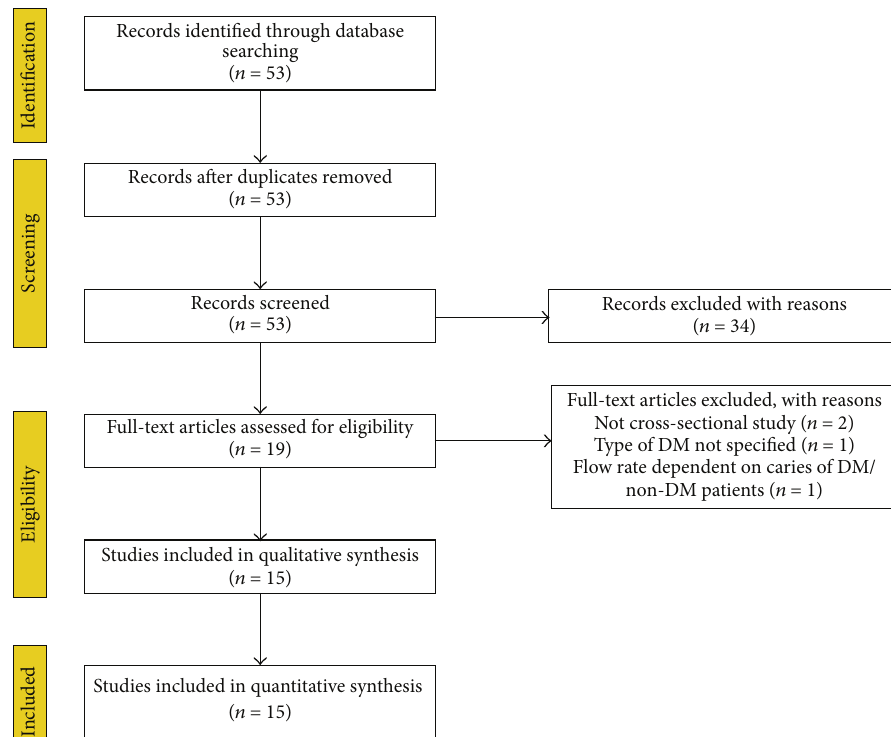
Figure 1: Flowchart of the systematic review